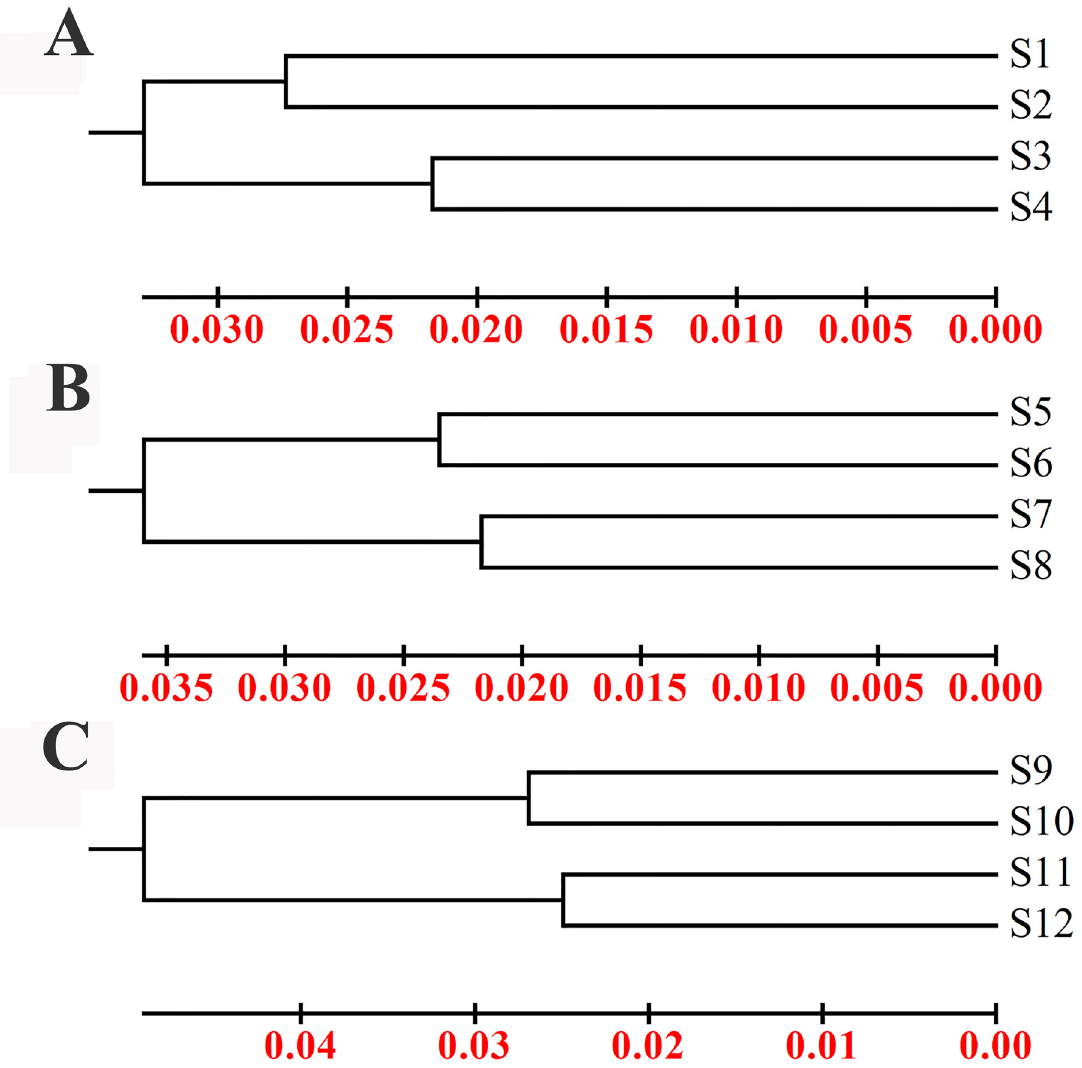
Fig 3. Cluster analysis based on the UPGMA of the DGGE profiles of the feces (A), soil (B) and intestinal content (C) samples. Scale bars indicate differences among the profiles.